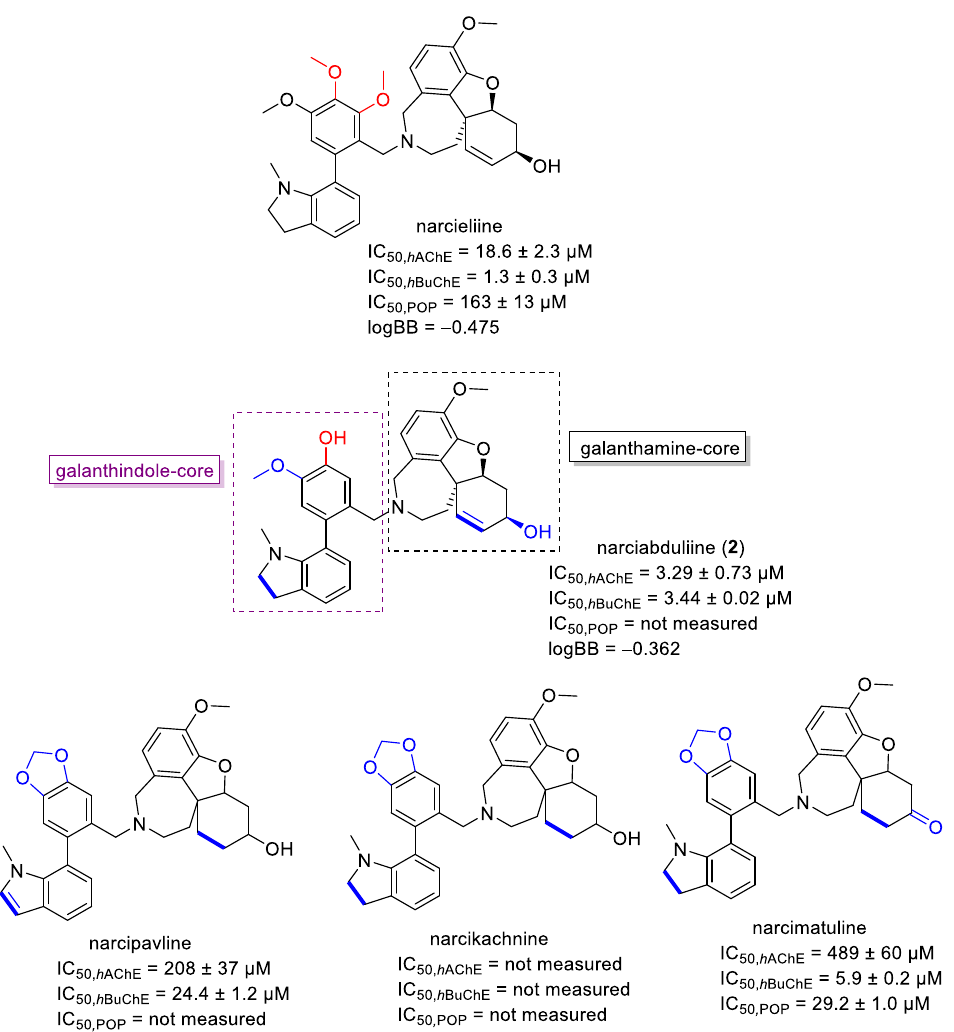
Figure 3. Structures of 2 and of recently isolated narcikachnine-type Amaryllidaceae alkaloids (structural differences of discussed alkaloids and 2 are marked in blue and red).